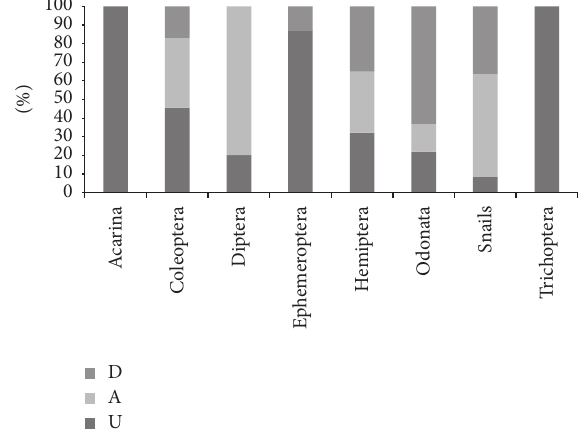
Figure 2: Relative abundance of main taxonomic group at each sampling